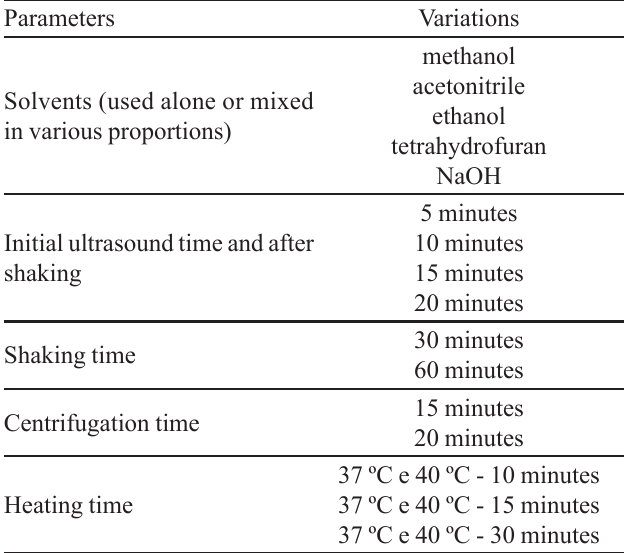
TABLE I - Altered parameters for drug extraction from the